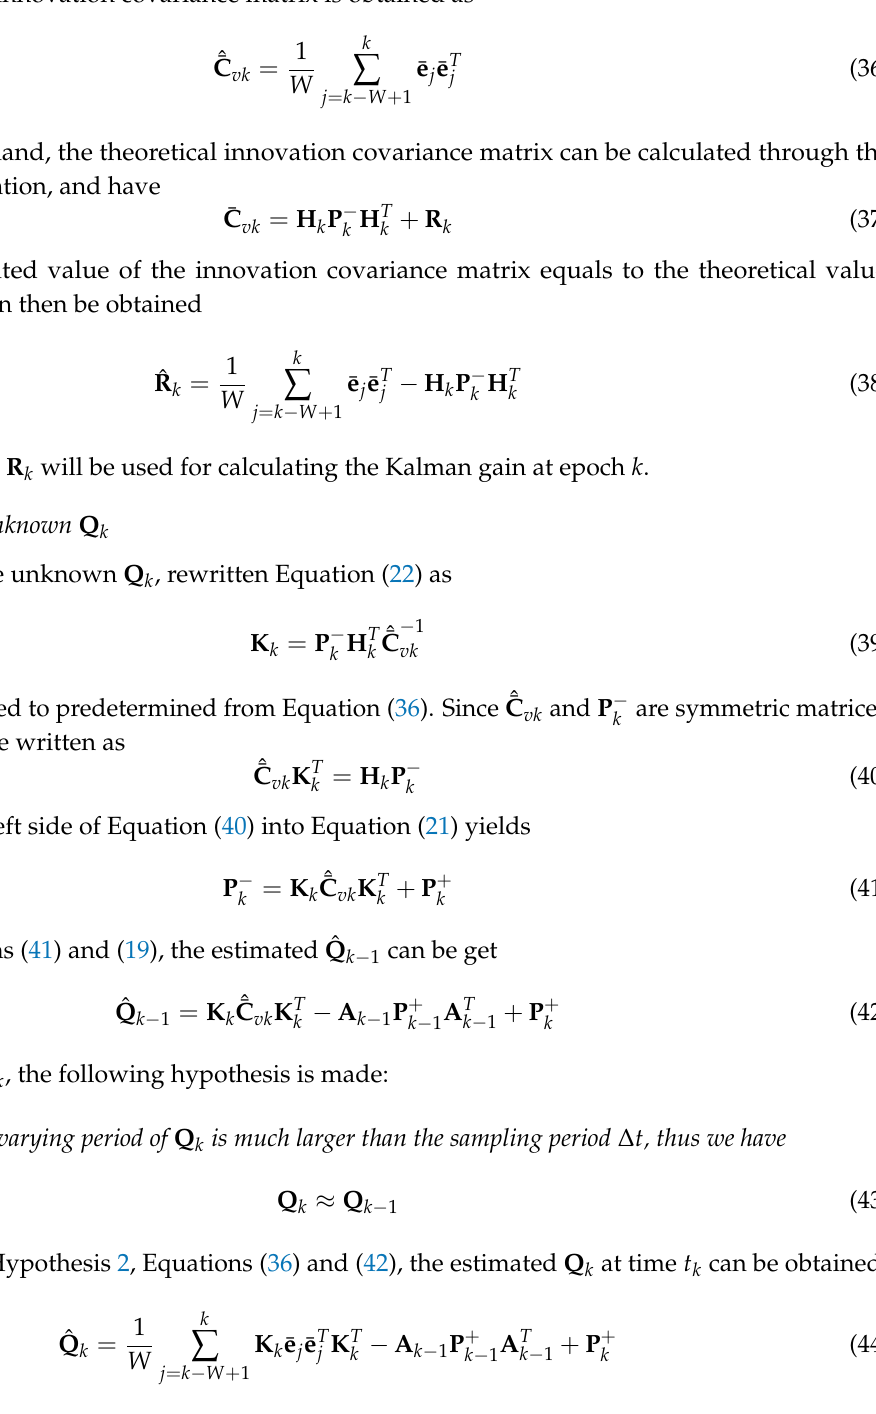
Algorithm 1 summarizes the detailed procedure of the Windows-based adaptive single-beacon underwater tracking